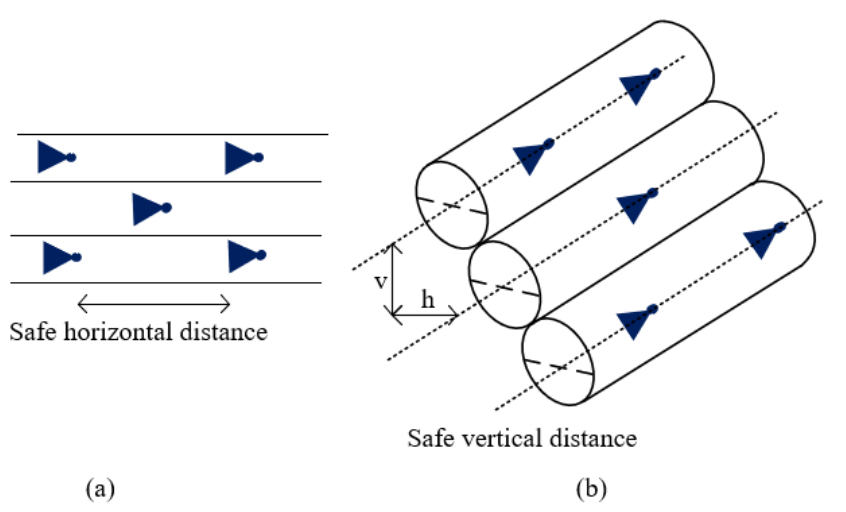
Figure 8. Multi-lanes in one direction: ( a ) vertical view, ( b ) 3D view: v—vertical safe distance, h—horizontal safe distance.